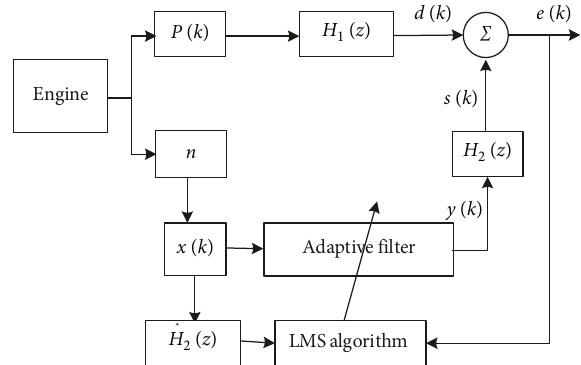
Figure 1: Active noise control system model of FXLMS algorithm.